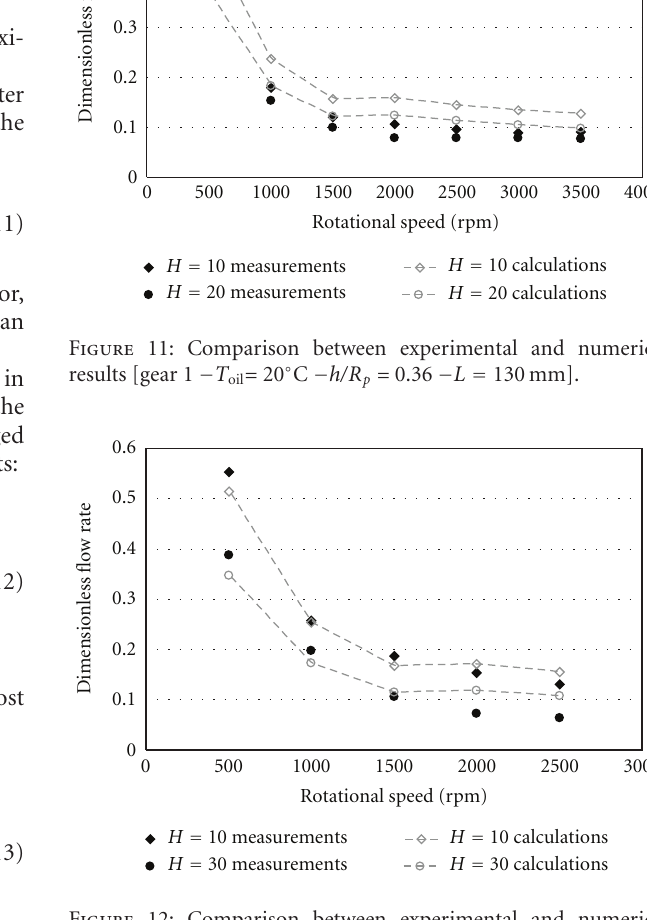
Figure 12: Comparison between experimental and